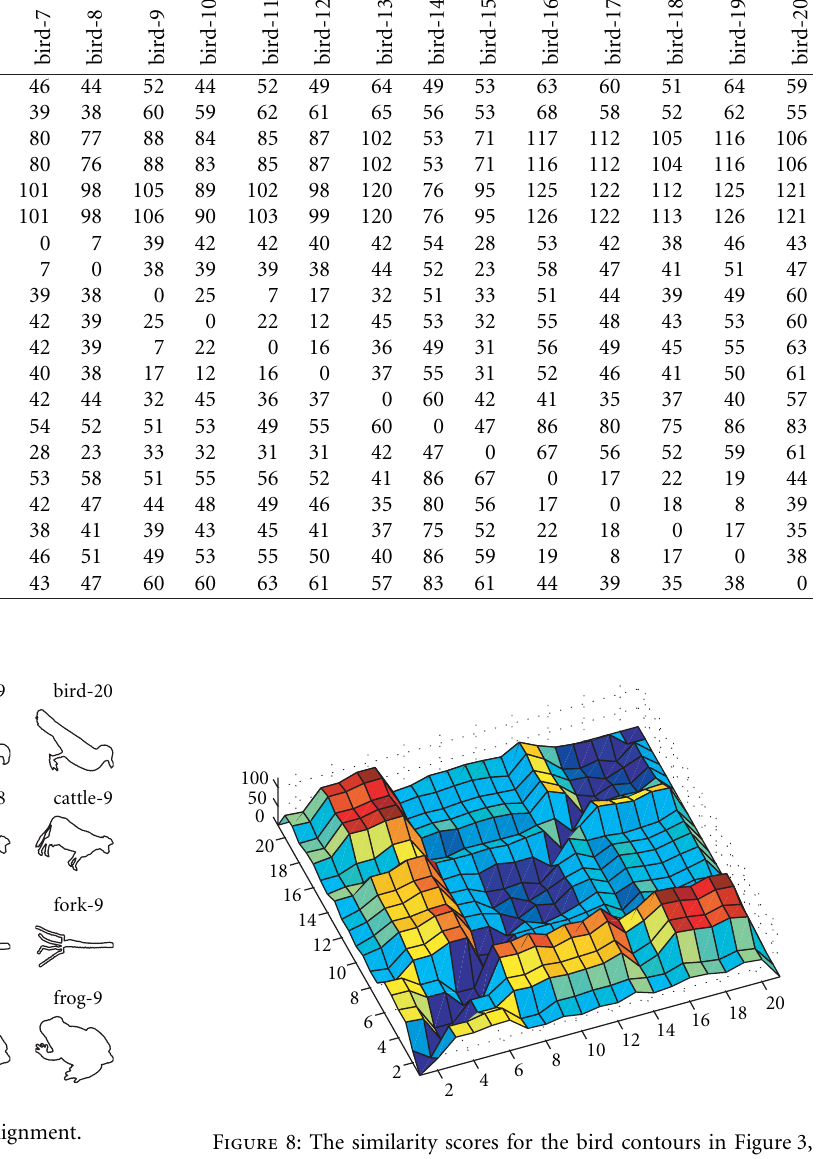
Figure 8: The similarity scores for the bird contours in Figure 3, dark blue cells mean most similar